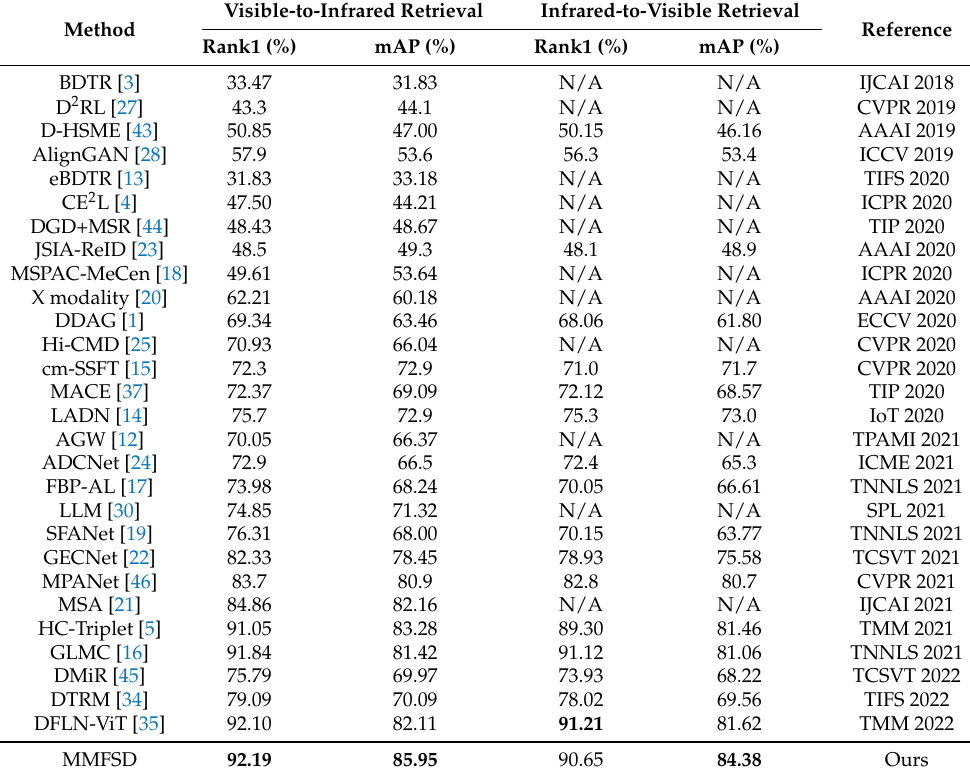
Table 2. The performance comparison on RegDB dataset.